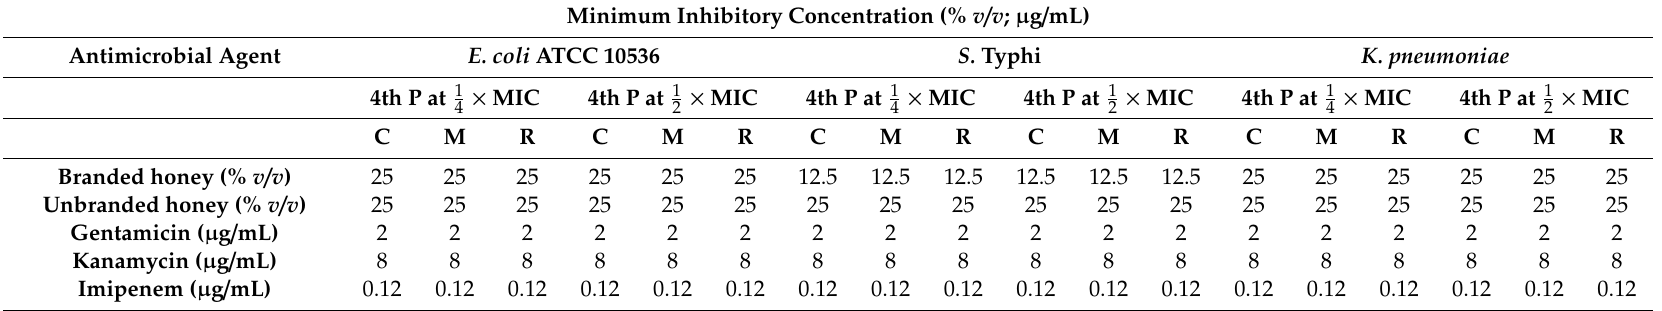
Table 2. Minimum inhibitory concentration (MIC) (% v / v ) of branded and unbranded honey against E. coli ATCC 10536, S. Typhi and K. pneumoniae after fourth × MIC of honeys (C: control; M: assay with branded honey; R: assay with unbranded passage of the cells at 1 and 1 2 4